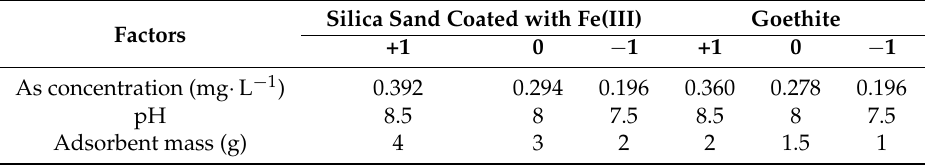
Table 2. Experimental design for the batch test.